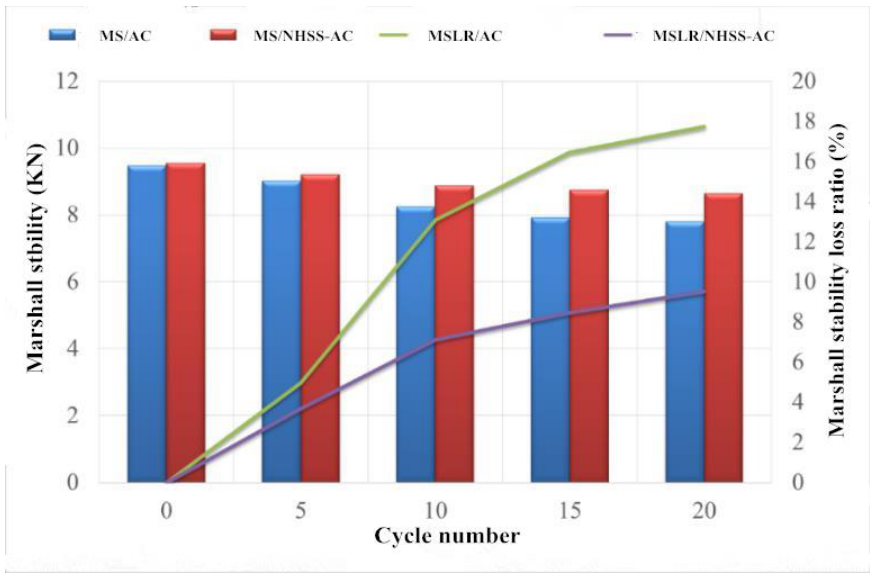
Figure 8. Marshall stability changes of mixtures under freeze – soak – scour cycles.